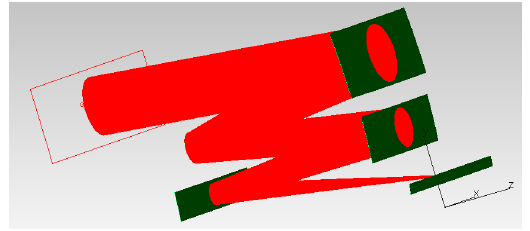
Figure 7. Analysis diagram of TracePro.